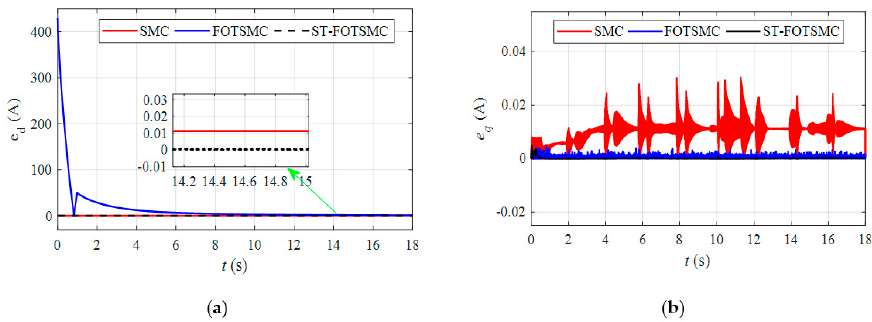
Figure 7. ( a ) e d under normal conditions; ( b ) e q under normal conditions. Energies 2020 , 13 , x FOR PEER REVIEW